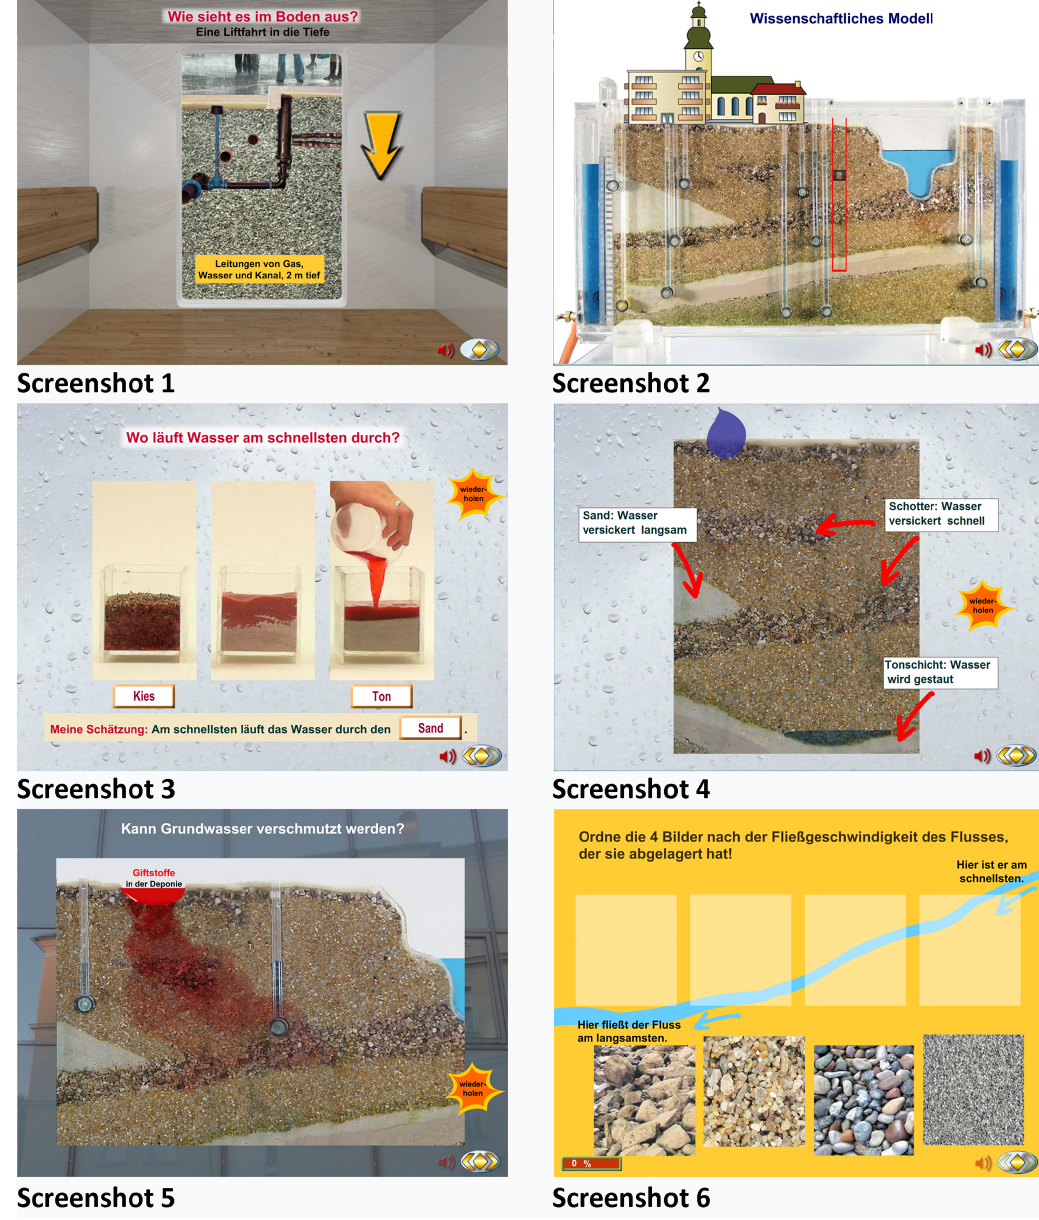
Figure 11. Screenshots from the multimedia learning